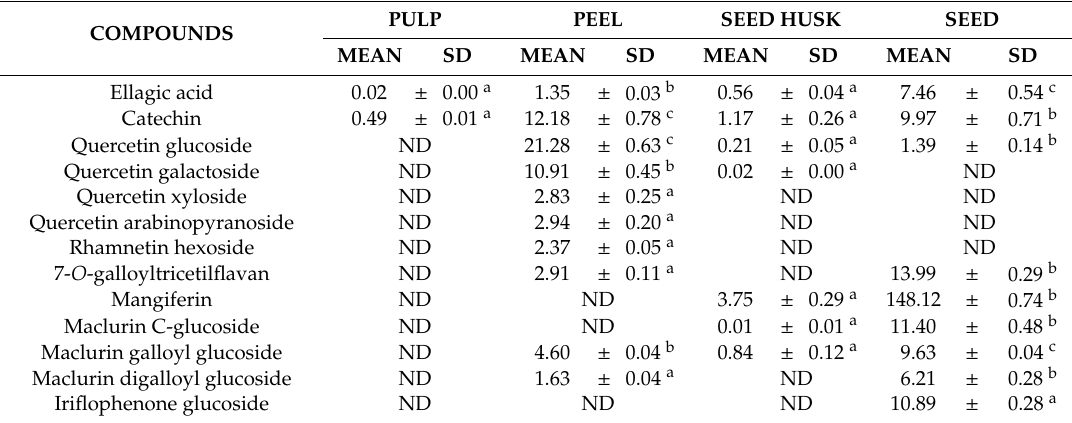
Table 3. Mean concentration of ellagic acid, flavonols, xanthones, and benzophenones from di ff erent parts of Keitt mango variety at optimum maturation stage expressed as mg / 100 g dry